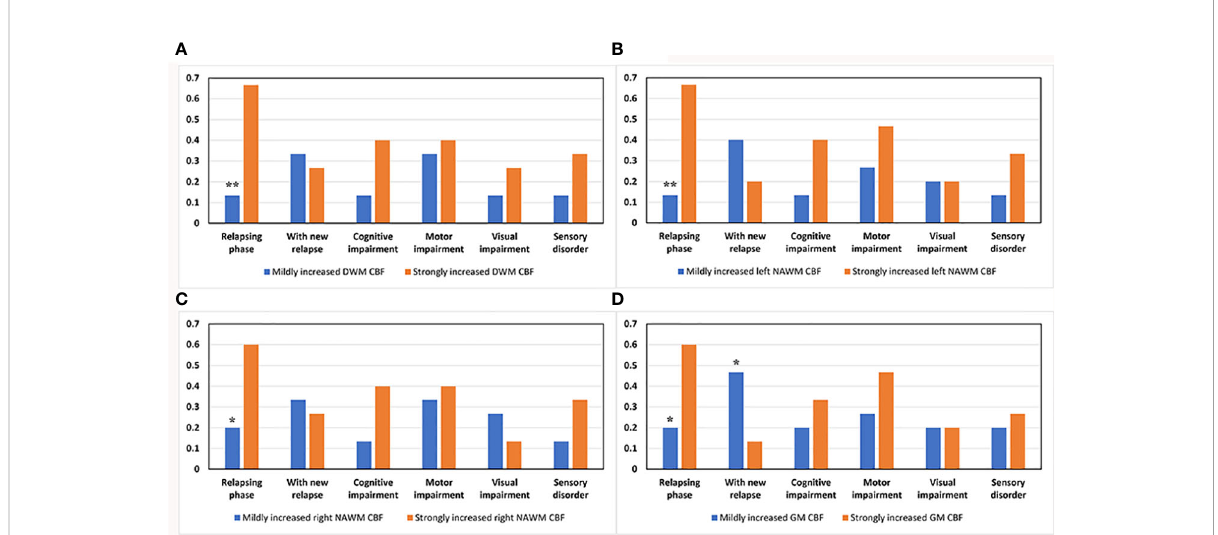
FIGURE 6 Comparison of various clinical parameters between the mildly and strongly increased CBF groups in DWM, NAWM, and GM. The strongly increased CBF group had a higher ratio of patients in the relapsing phase than the mildly increased CBF group in (A) DWM ( p = 0.003), (B) left NAWM ( p = 0.003), (C) right NAWM ( p = 0.025), and (D) global GM ( p = 0.025). (D) The low GM CBF group had a higher ratio of patients experiencing relapse after the neuroimaging examination than the high GM CBF group ( p = 0.046). * p < 0.05 and ** p < 0.01 vs. strongly increased group.